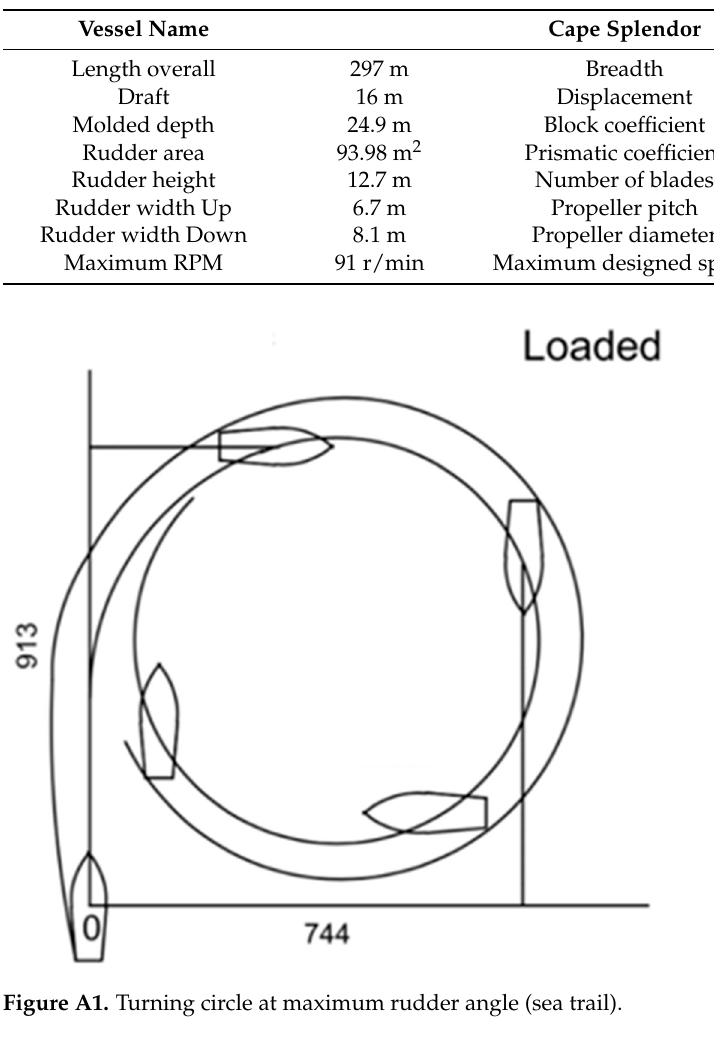
Table A1. Simulated parameters for the bulk carrier.